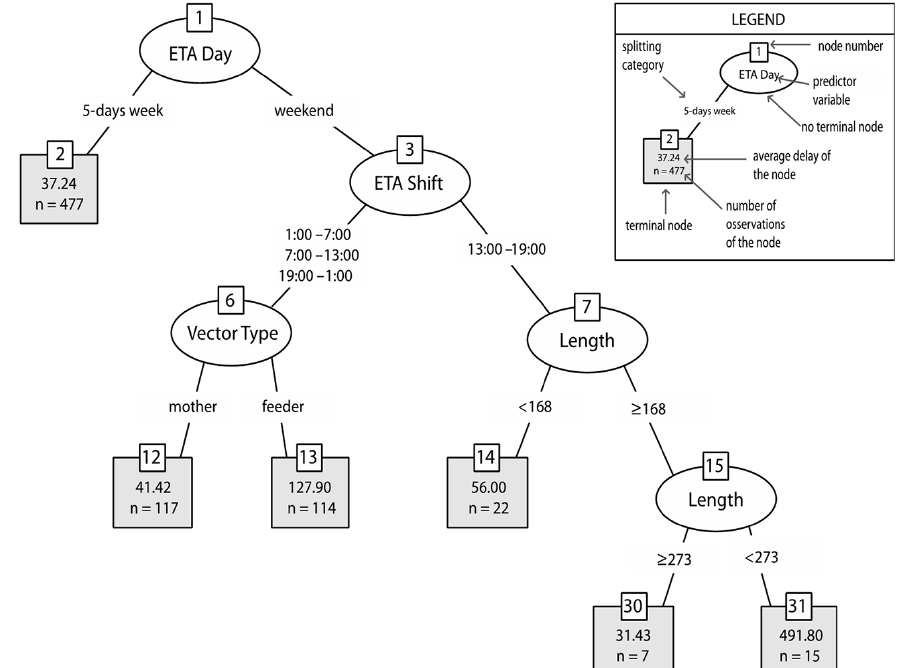
Fig. 6. Regression